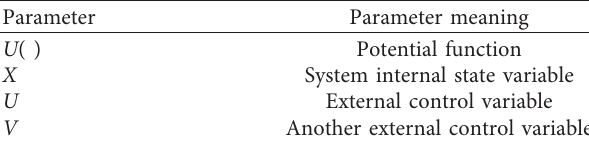
Table 1: Meaning of parameters in